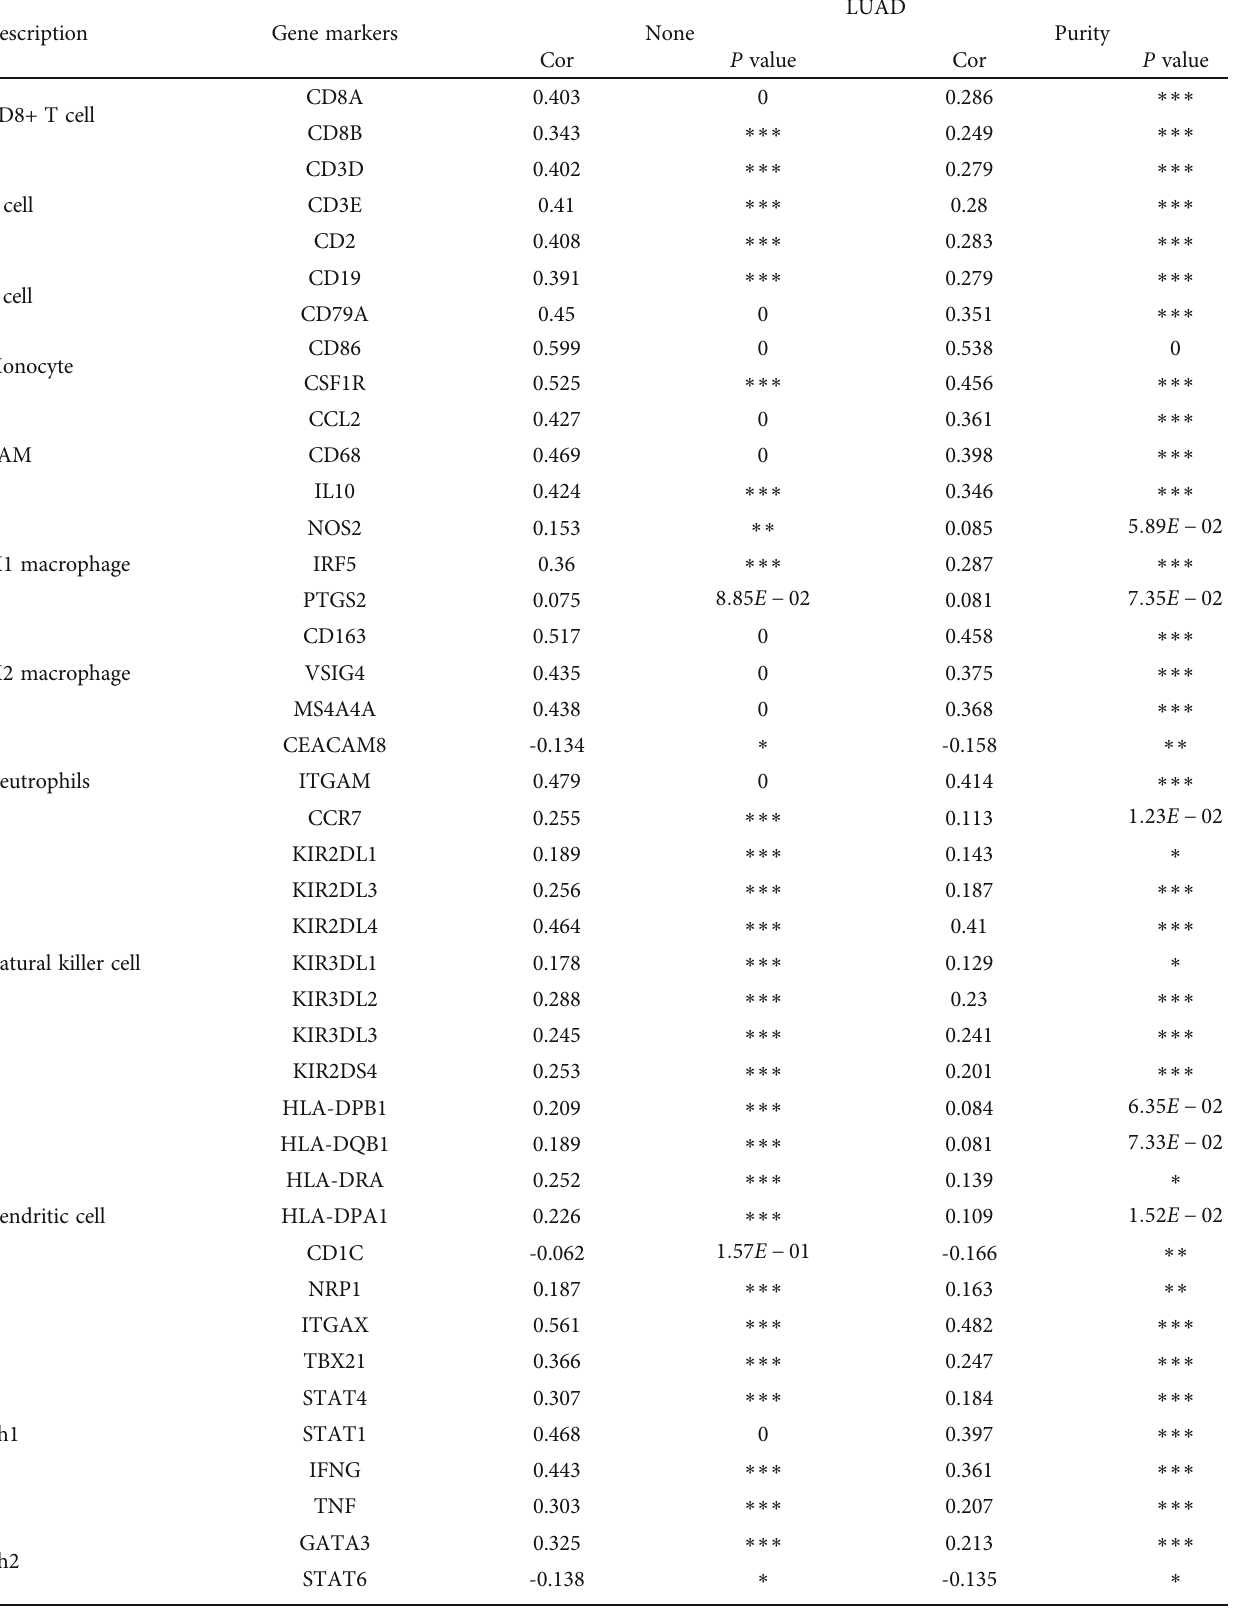
Table 2: Correlation analysis between SLC2A5 and related genes and markers of immune cells in